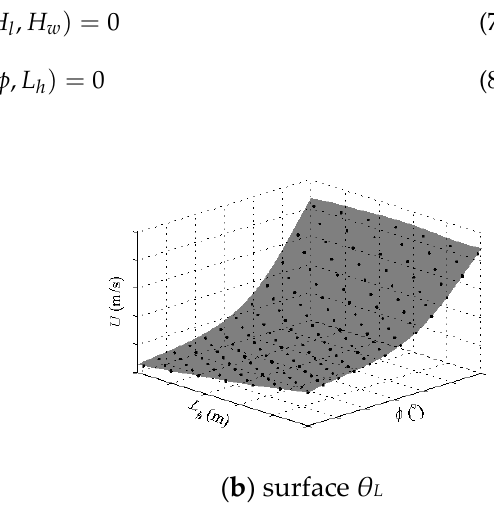
Figure 2. Capacity surfaces of transmission towers .